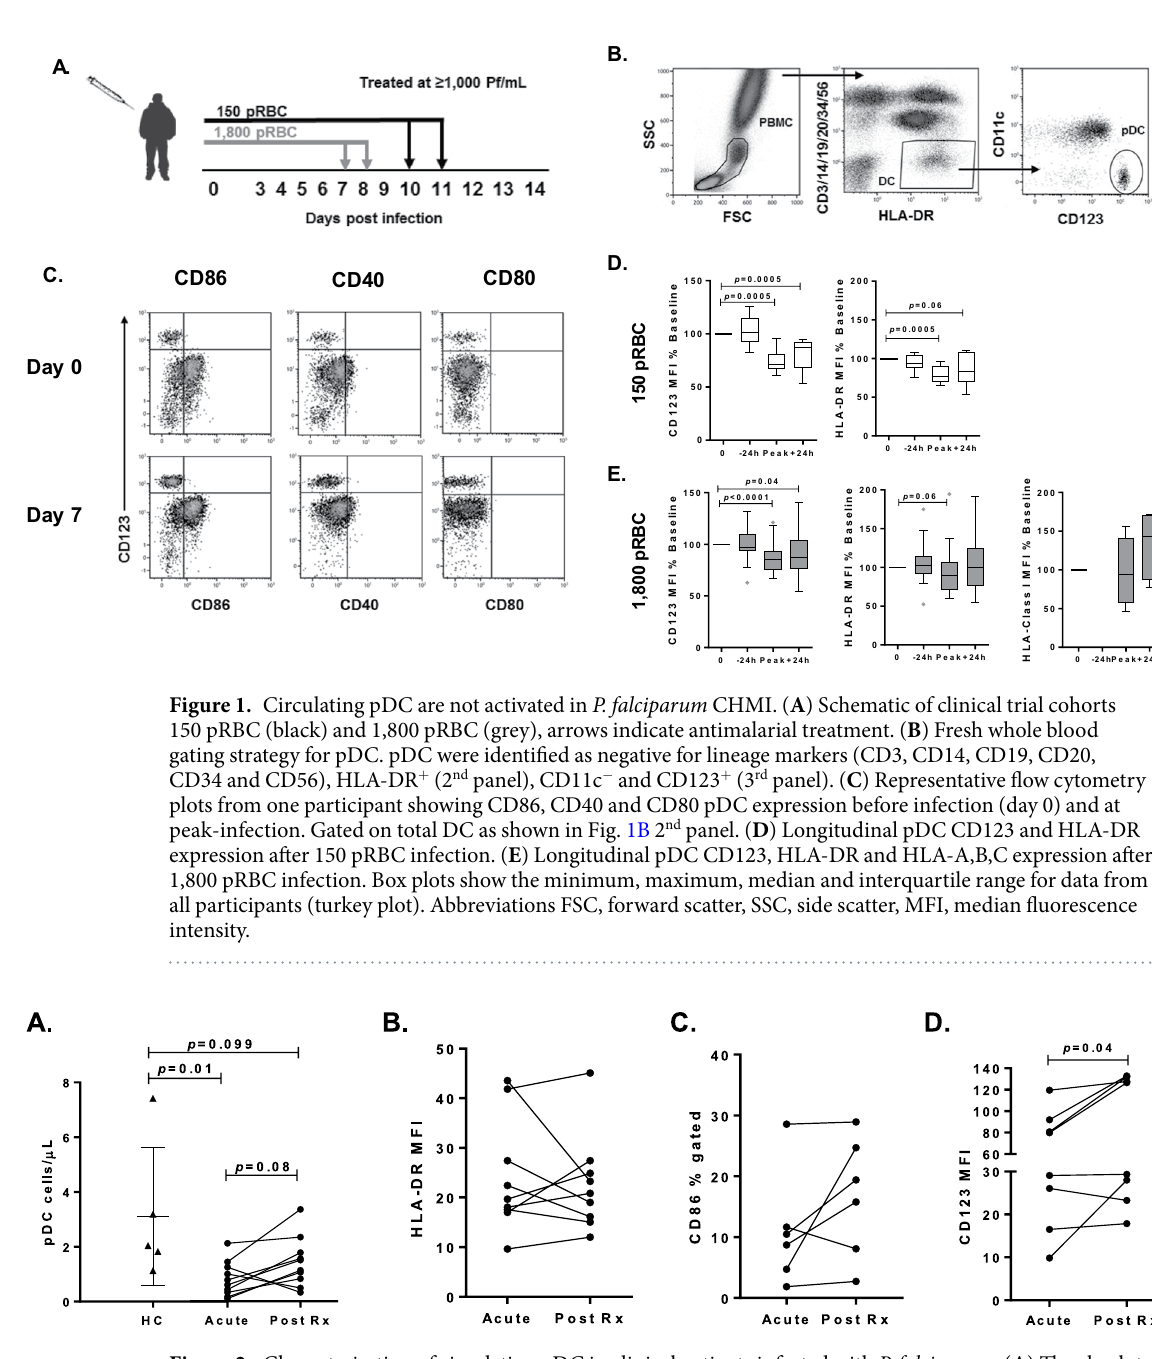
Figure 2. Characterisation of circulating pDC in clinical patients infected with P. falciparum . ( A ) The absolute number of circulating pDC in 5 healthy controls (black triangles) and 10 patients with acute P. falciparum and at convalescence, 14 to 28 days after antimalarial drug treatment (Post Rx). ( B ) Longitudinal HLA-DR expression (MFI) on pDC of patients with acute P. falciparum malaria. ( C ) Longitudinal CD86 percent positive pDC of patients with acute P. falciparum malaria. ( D ) Longitudinal CD123 expression (MFI) on pDC of patients with acute P. falciparum malaria. Mann-Whitney t-test was used for comparison between healthy controls and clinical malaria patients. Wilcoxon matched-paired test was used for comparison between acute malaria and convalescence (Post Rx). Abbreviations: MFI, median fluorescence